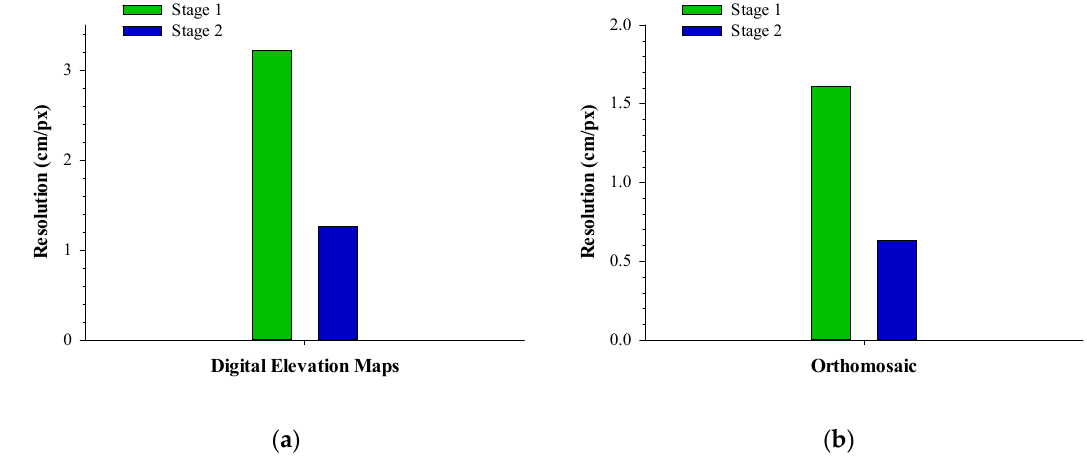
Figure 10. Comparison of ( a ) DEM and ( b ) orthomosaic resolutions for Stage 1 and Stage 2 flights.